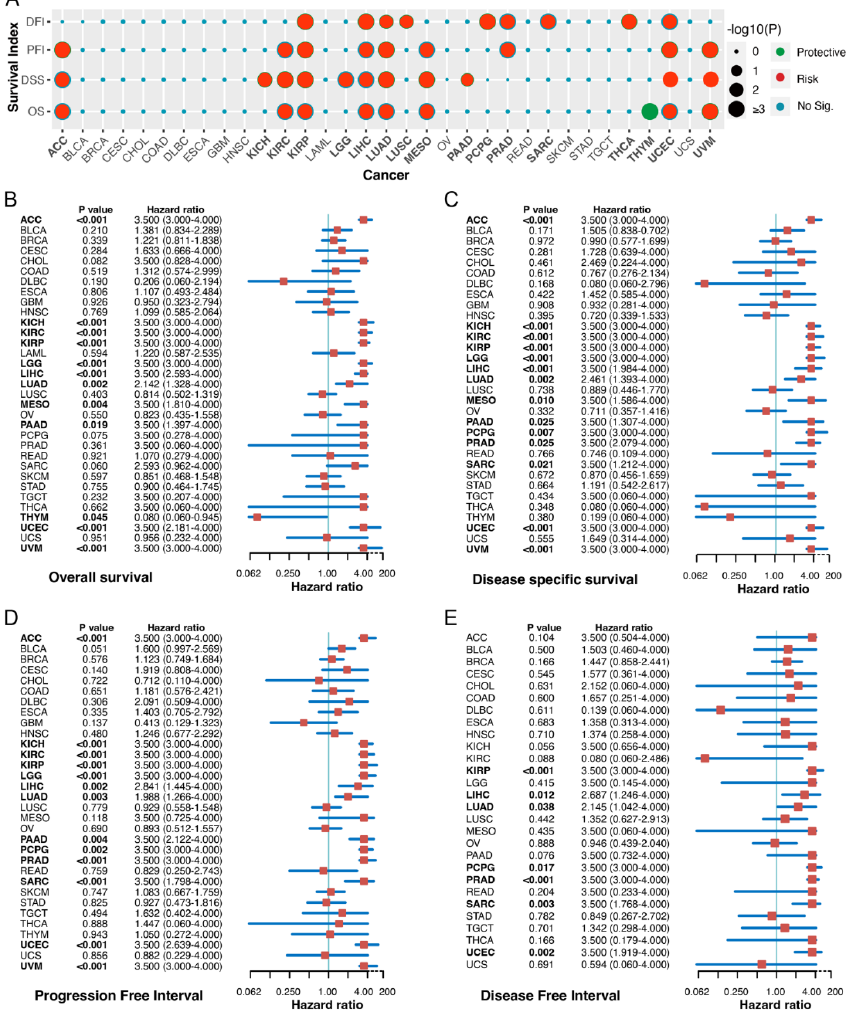
Figure 2. Correlation between the expression of FAM72A and prognosis in pan-cancer. ( A ). Kaplan- Meier survival analyses were performed to determine the association between FAM72A and several